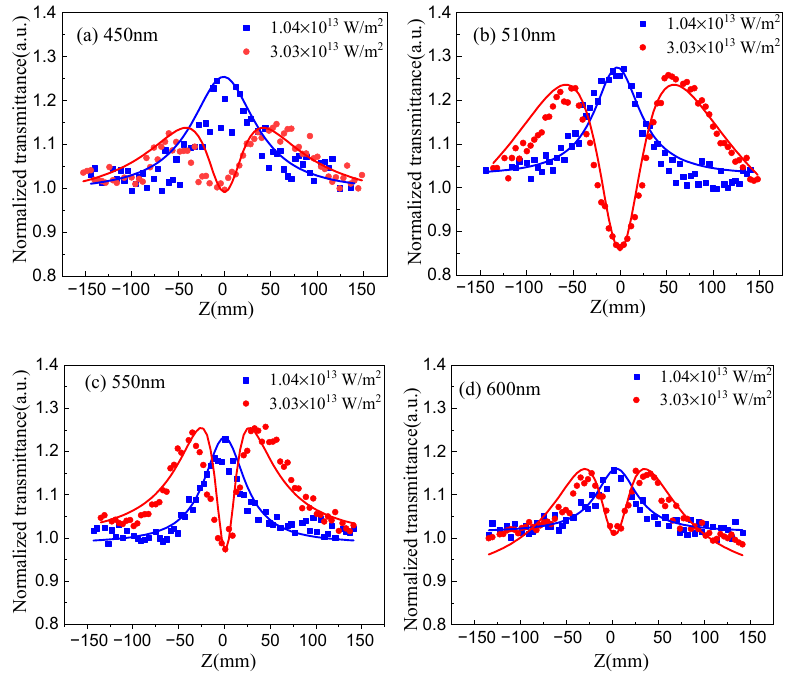
Figure 3. The normalized open-aperture (OA) Z-scan transmittance of the Au-Ag NPs obtained at wavelengths of ( a ) 450 nm, ( b ) 510 nm, ( c ) 550 nm, ( d ) 600 nm. The red and blue dots are experimental data, and the red and blue solid lines are theoretical one.